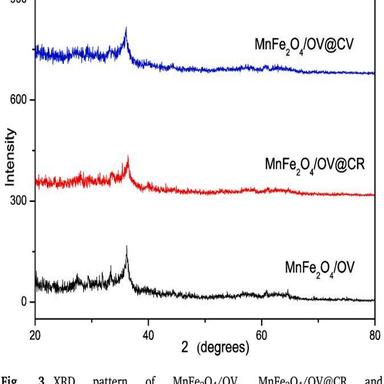
XRD pattern of MnFe2O4/OV, MnFe2O4/OV@CR and MnFe2O4/OV@CV